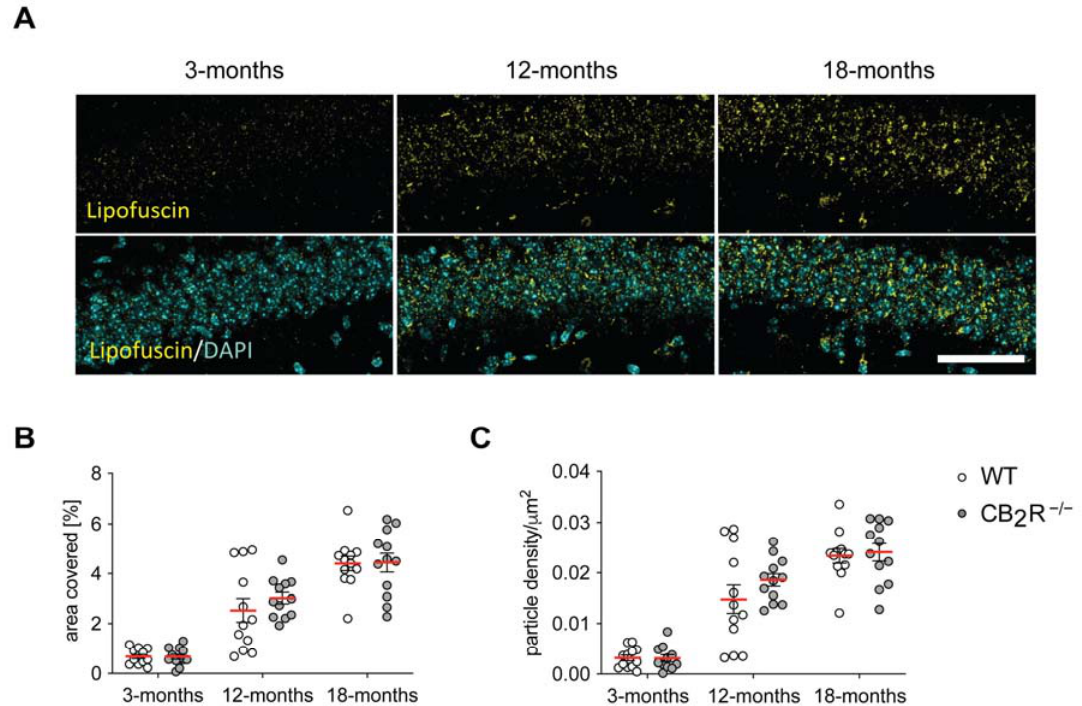
Figure 3. Accumulation of Lipofuscin in hippocampal pyramidal neurons during aging is not altered by CB2 deletion. Representative microscopy images of Lipofuscin accumulation in hippocampal pyramidal neurons with a scale bar of 50 µ m ( A ). The area covered with lipofuscin ( B ) and the particle density ( C ) show a significant increase but is not different between WT and CB 2 R − / − mice. WT mice—white circle; CB 2 R − / − mice—grey circles. N = 6 mice/genotype/age group, two substacks per animal. Each point represents a single substack. Red line indicates the mean value ± SEM. Two-way